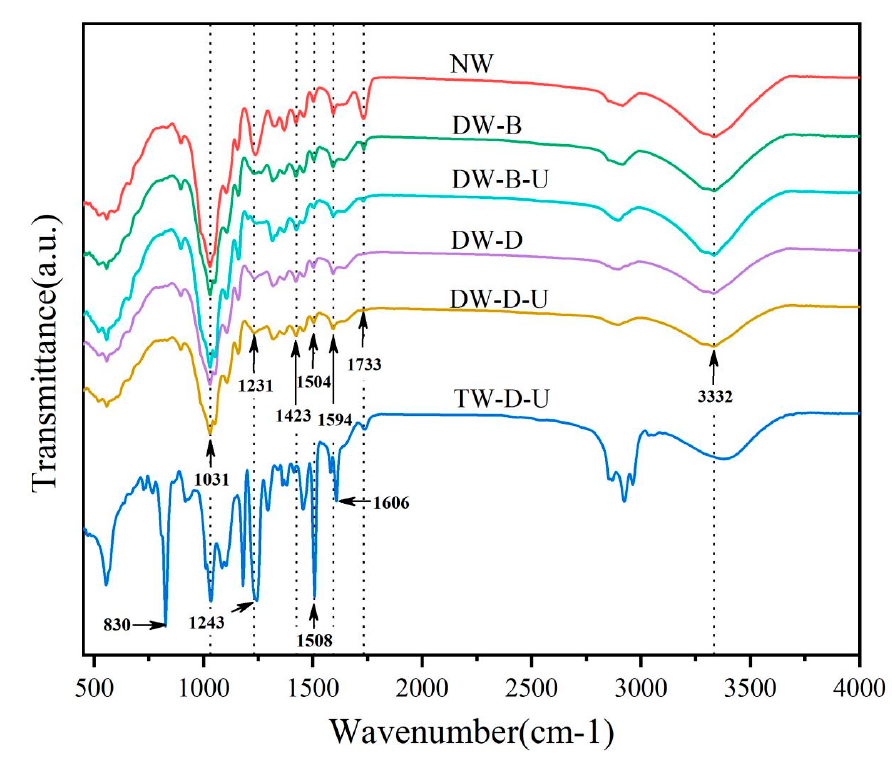
Figure 5. Infrared spectral images of natural wood NW, four groups of delignified wood DW − B, DW − B − U, DW − D, DW − D − U and “transparent wood” TW − D − U.